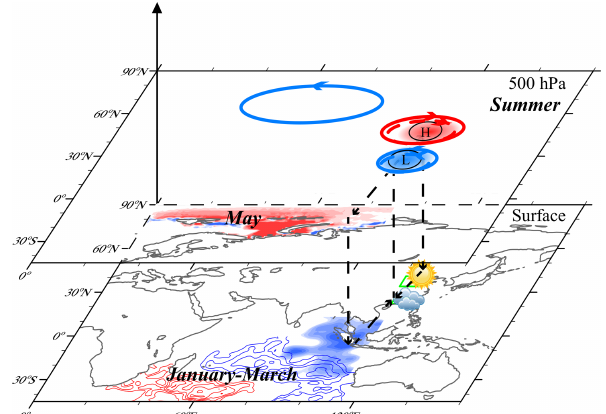
Figure 10. Schematic diagrams of the associated physical mech- anisms. The May SI anomalies near Franz Josef Land (red shad- ings) could trigger an EU-like pattern in the atmosphere in summer, which enhances the anticyclonic anomaly over NC and the cyclonic anomaly over the PRD. The thermodynamic signal of the preceding SIOD (contours) could be stored in the subsurface, and the center of negative SST anomalies moves to the vicinity of Sumatra in summer (blue shading). The meridional circulation was enhanced in summer (dashed lines), along with the enhancement of AC NC and C PRD over eastern China. The solid lines indicate the anomalous atmo- spheric circulations affected by SI FJL , while the dashed lines indi- cate the anomalous atmospheric circulations affected by